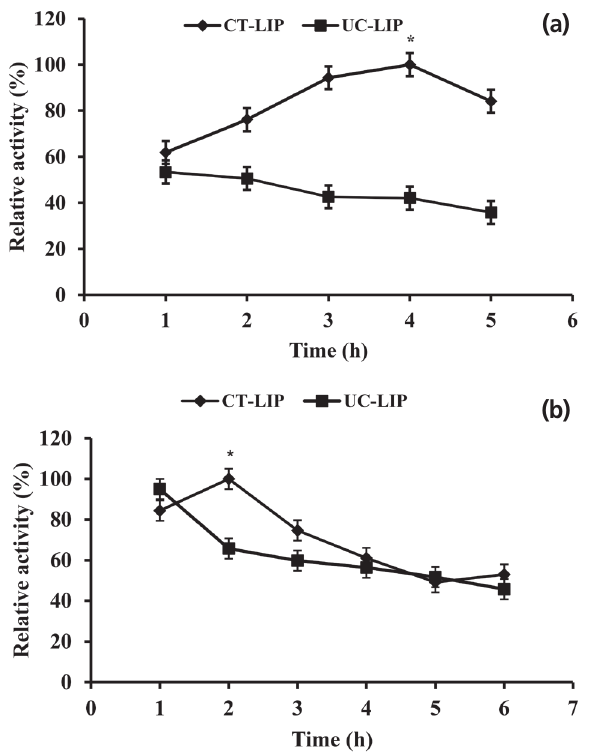
Figure 4. Effect of simulated gastrointestinal fluid on the lipase relative activity. (a) Effect of simulated gastric fluid (SGF) on the lipase relative activity. (b) Effect of simulated intestinal fluid (SIF) on the lipase relative activity. Data were presented with mean±standard deviation (n = 6). Vertical error bars show standard deviation of measured relative activity (*